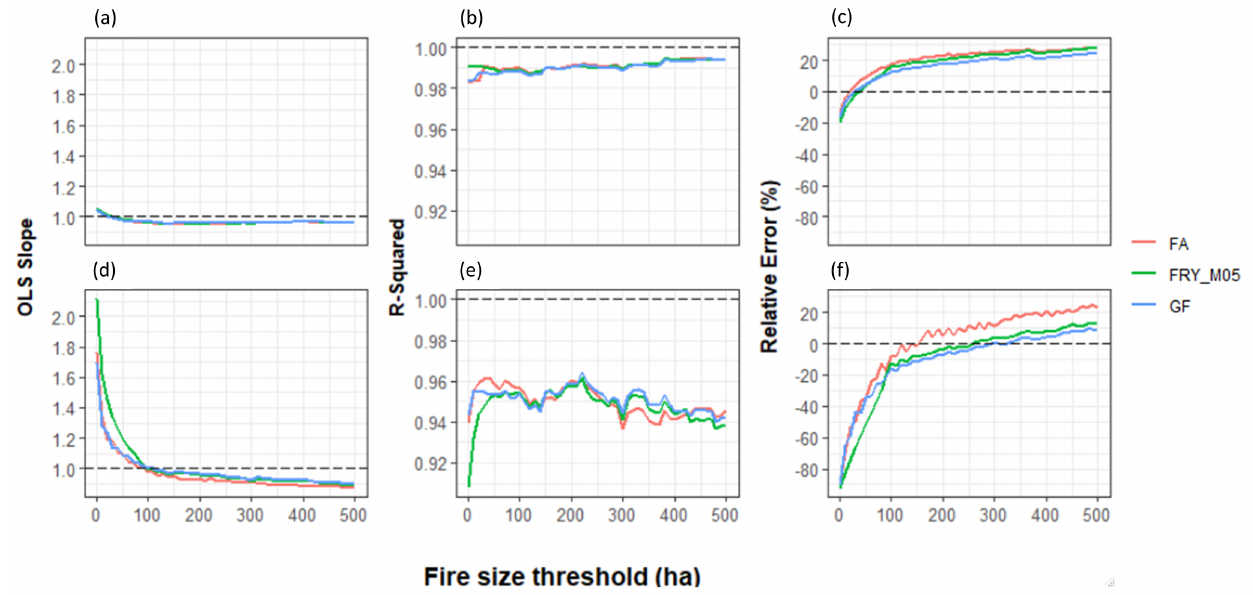
Figure A2. Evaluation of “raw” RSDs (i.e., without the land cover filter) through different metrics including the slope (a, d) , R 2 correla- tion (b, e) , and relative error (c, f) for both burned area (a–c) and the number of fires (d–f) over a range of individual fire size thresholds (1 to 500ha). Dashed lines indicate a perfect fit between RSDs and the